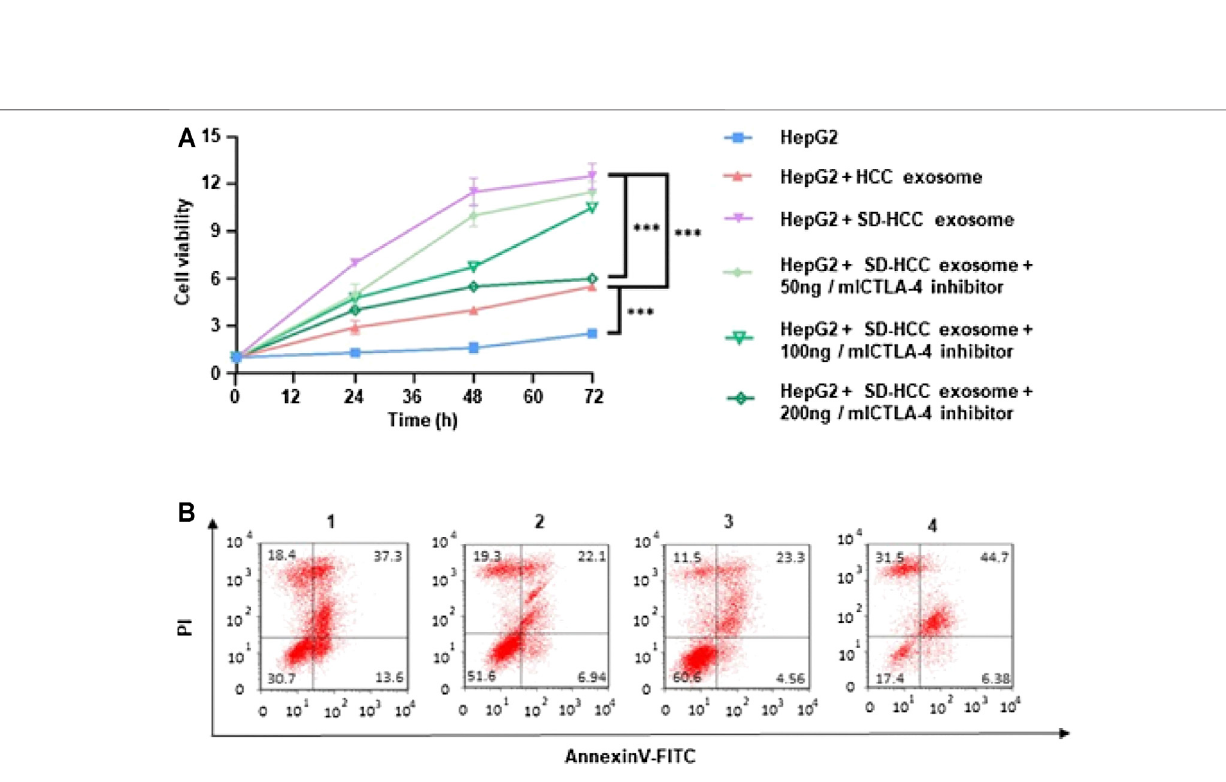
Frontiers in Pharmacology |